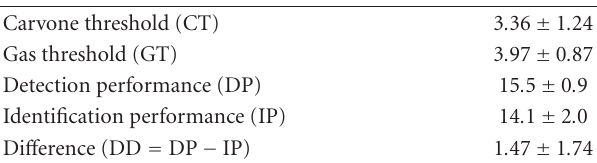
Table 3: Mean scores and standard deviations for 407 healthy participants.